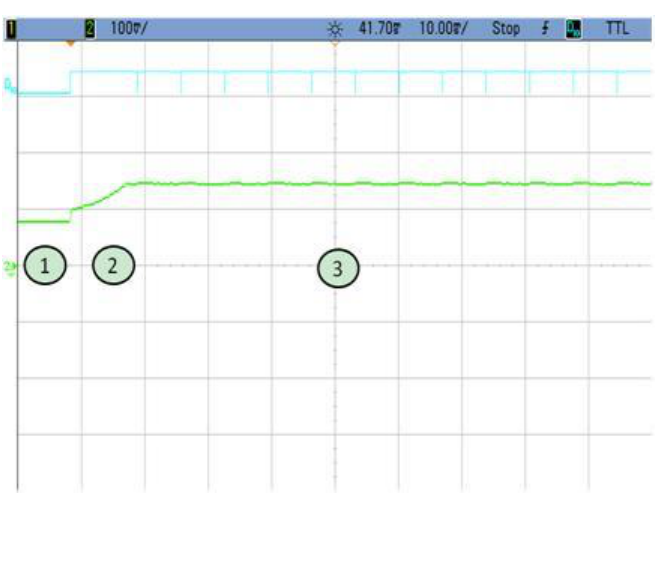
Figure 14. Test 5